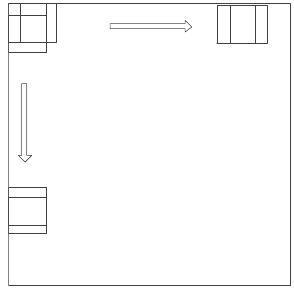
Figure 4. Strategy of 3/4 overlap